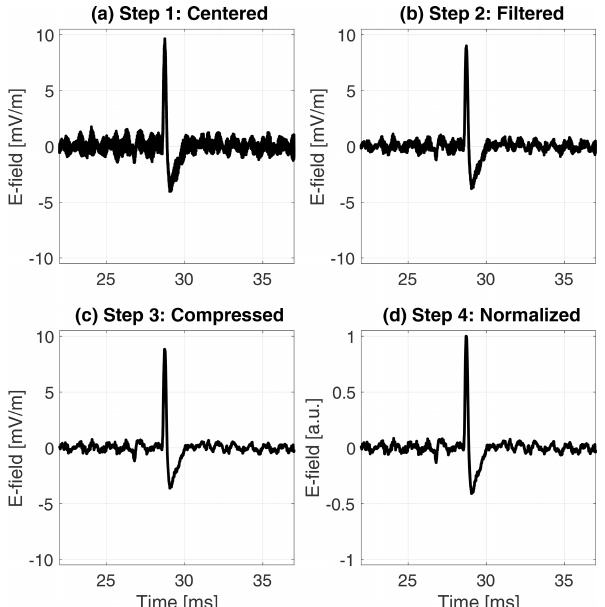
Figure 2. A dust waveform observed by antenna 2 on 8 Septem- ber 2021. The panels illustrate the different stages of the pre- processing procedure. (a) The electric field offset is removed and the signal is centered around 0mVm − 1 . (b) The signal is filtered by a median filter over seven time steps to reduce the high-frequency noise. (c) The signal is compressed by a factor of 4 to reduce the data size. (d) The waveform is normalized by the maximum abso- lute value of the signal in order to ease the parameter optimization of the machine learning classifier. Note the waveform is zoomed to a 15ms time period around the dust impact in order to better visual- ize the impact shape modification by the pre-processing